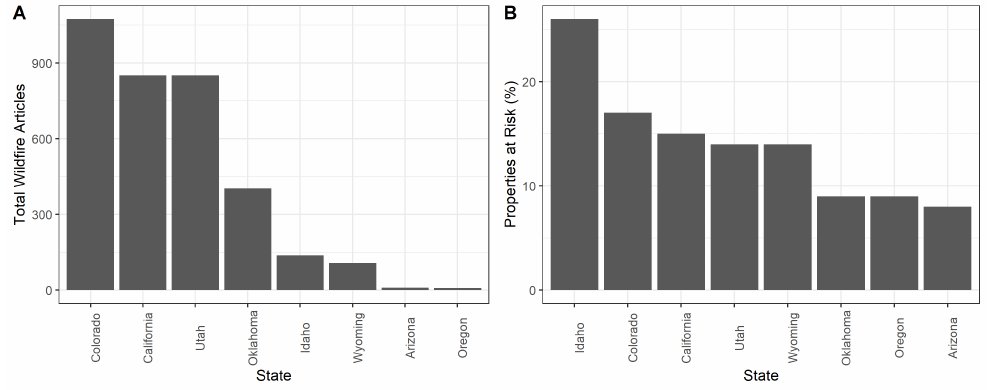
Figure A3. Top States for Wildfire Coverage ( A ) vs. Wildfire Risk based on the percentage of properties at risk ( B ).